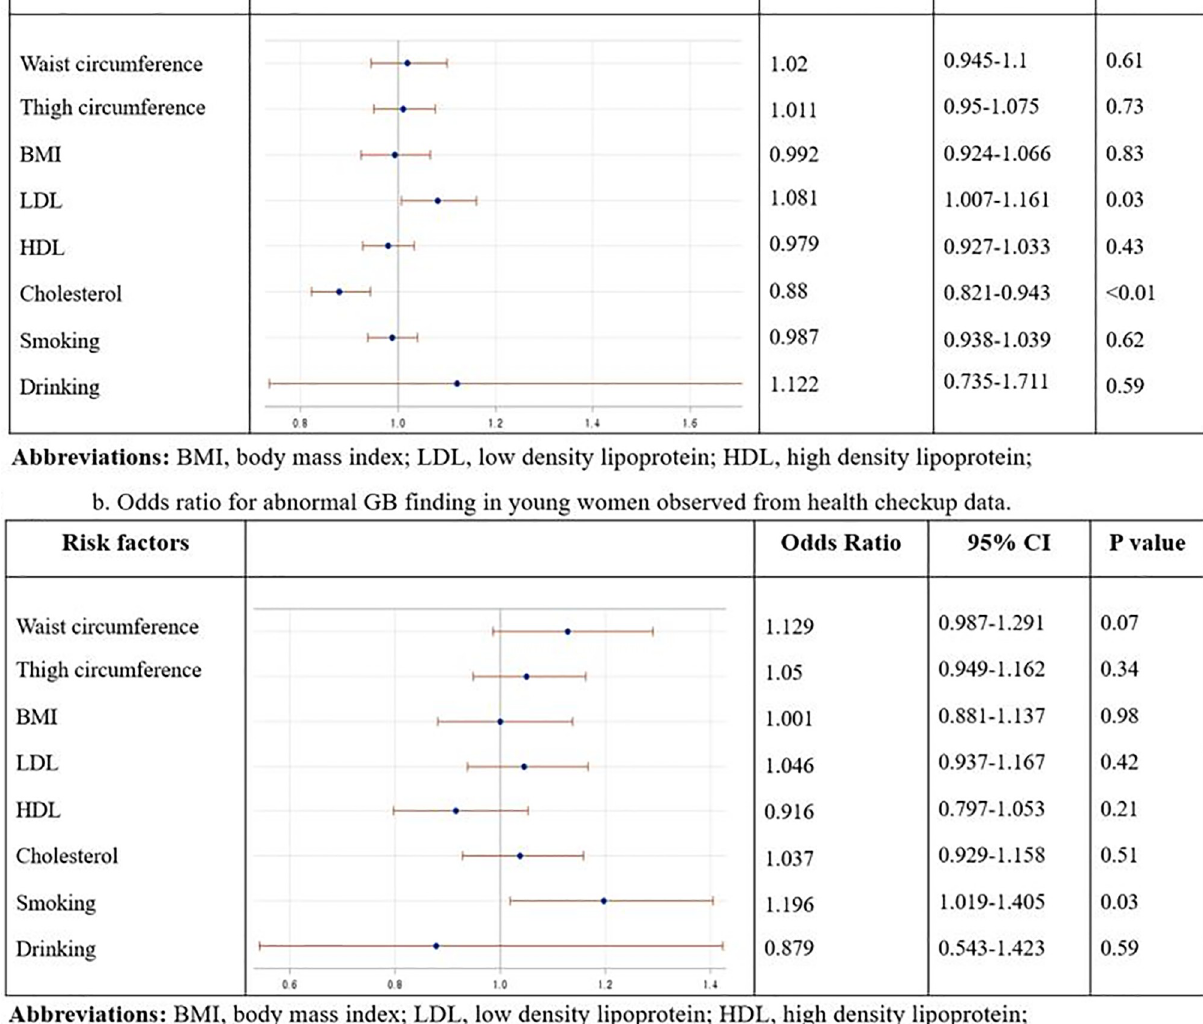
Fig 2. Odds ratios for abnormal GB finding in young men (A) and women (B) observed from health checkup data.